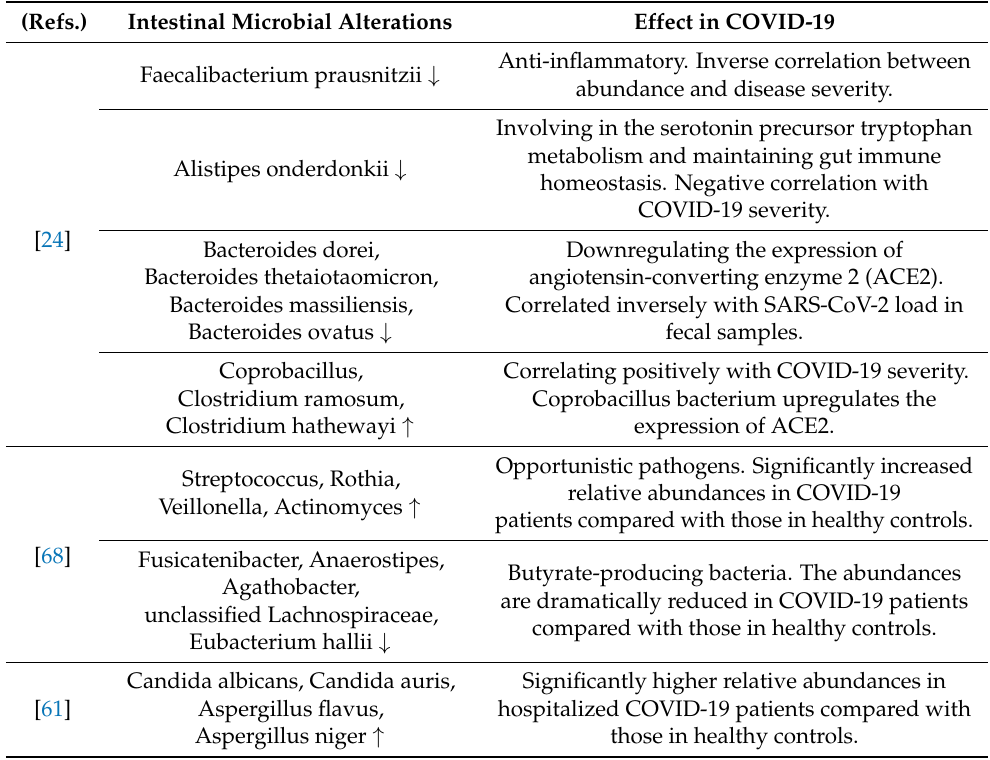
Table 1. Intestinal microbial alterations and their effect in COVID-19.